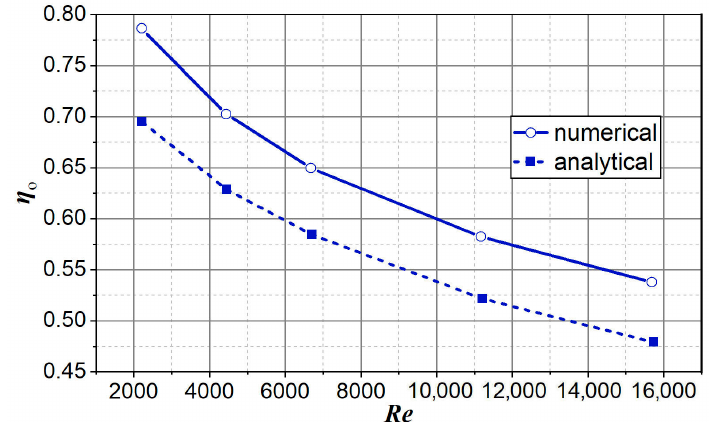
Figure 17. The overall surface efficiency η o determined numerically and analytically.